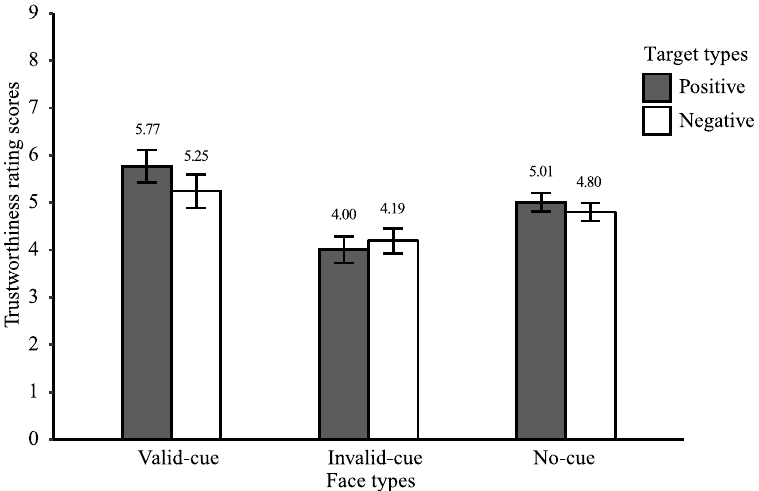
Fig 4. Facial trustworthiness for each type of gaze and emotional valence in Experiment 1. Error bars represent the standard error of the mean ( SEM ). Means of trustworthiness scores for each condition are shown above each bar.